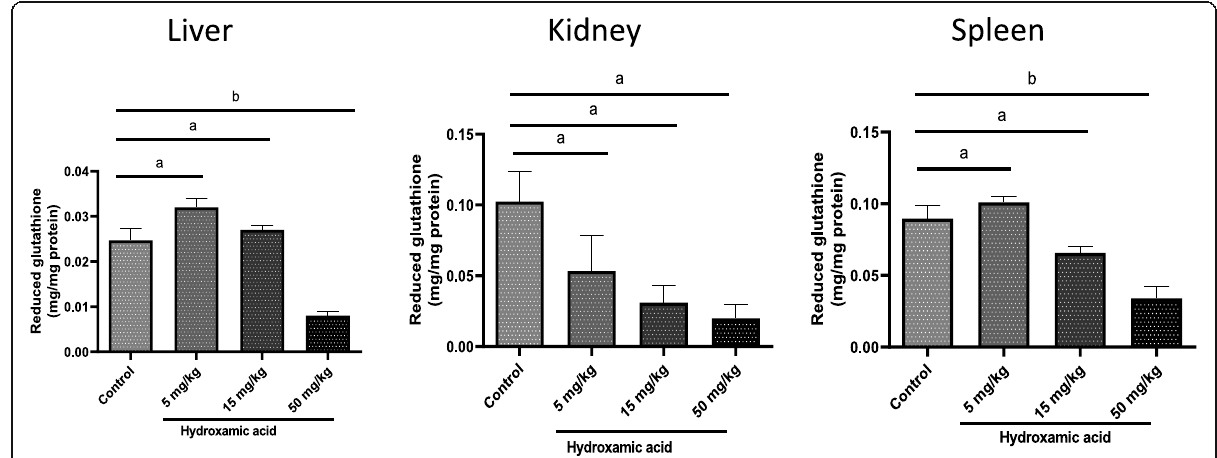
Fig. 5 Reduced glutathione level in liver, kidney, and spleen. Values are expressed as mean ± SEM; ( n = 5).Different letters indicate significant difference at p < 0.05